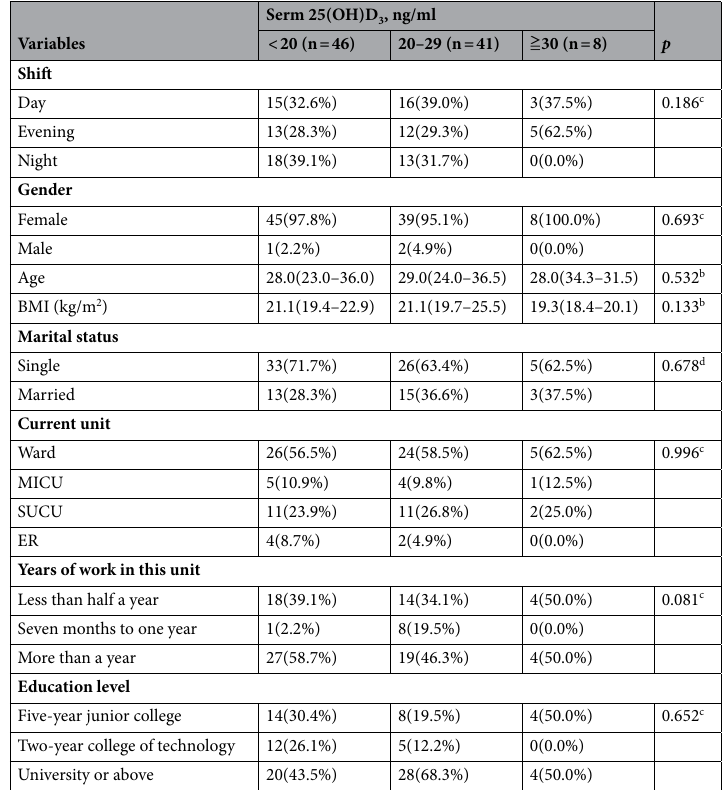
Table 3. The characteristics of three class shift nurses according to 25(OH)D 3 concentrations. BMI, body mass index; MICU, Medical Intensive Care Unit; SICU, surgical intensive care unit; ER, emergency room. * p -value < 0.05. The power after calculation and analysis after the event: the number of subjects is 95 (n = 95), and the ANOVA test is carried out in three groups, and the calculated power is 0.6550386. a Data were continuous and presented as mean ± SD using ANOVA. b Data were continuous and presented as median (IQR) using Kruskal–Wallis test. c Data were categorical and presented as n (%) using Fisher’s exact test. d Data were categorical and presented as n (%) using chi-squared